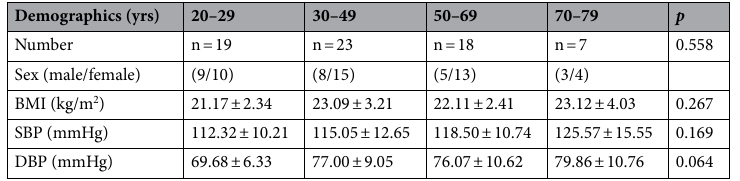
Table 1. Demographic Characteristics of the Different Age Groups. Mean ± SD. BMI, body mass index; SBP, systolic blood pressure; DBP, diastolic blood pressure. Chi-square test and Kruskal–Wallis test were